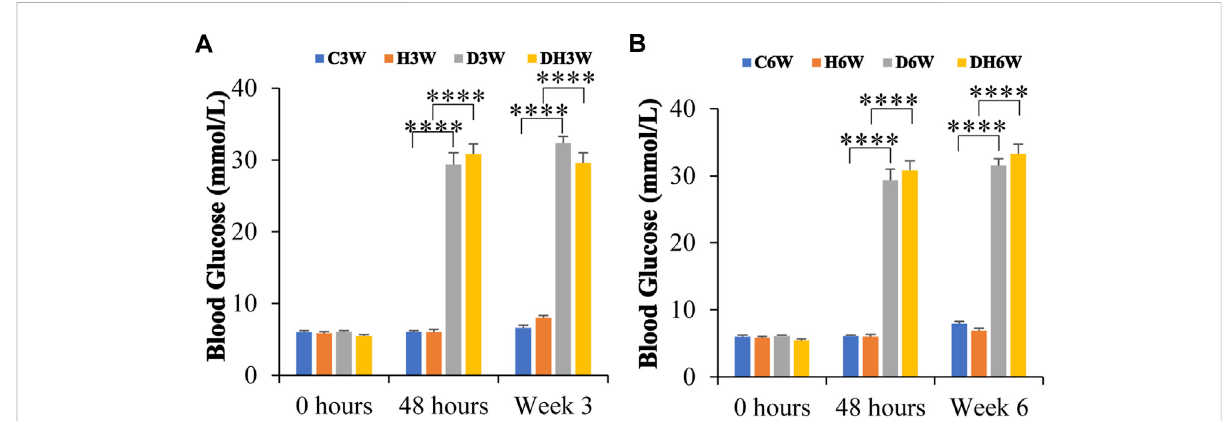
FIGURE 1 Blood glucose levels of ratsindifferentgroups inshort-term (A) andlong-term (B) experiments. Notethat there wereno signi fi cant differences in blood glucose levels between groups before STZ injection (0 h) in both short and long-term experiments. However, the diabetic and diabetic + heat therapy group ofrats (D3W, DH3W,D6W, and DH6W) showed a signi fi cant increase in bloodglucose compared to respective control groupsat all-time points of measurements (48 h, 3 and 6 weeks) after STZ injection (****, p < 0.0001, One-way ANOVA, Bonferroni multiple comparison tests, n = 6 in all groups) and there was no difference in blood glucose level between short- and long-term experiments.